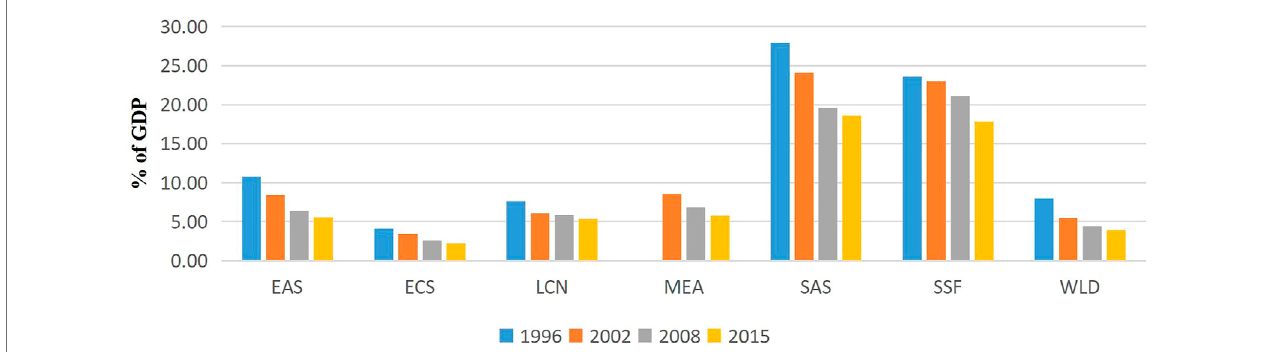
FIGURE3| AgriculturecontributiontoGDP.note:EAS,EastAsiaandPaci fi c;ECS,EuropeandCentralAsia;LCN,LatinAmericaandCaribbean;MEA,MiddleEast and North Africa; SAS, South Asia; SSF, Sub-Saharan Africa; Trade costs are the summation of costs, documents, and time to trade. Source: WDI